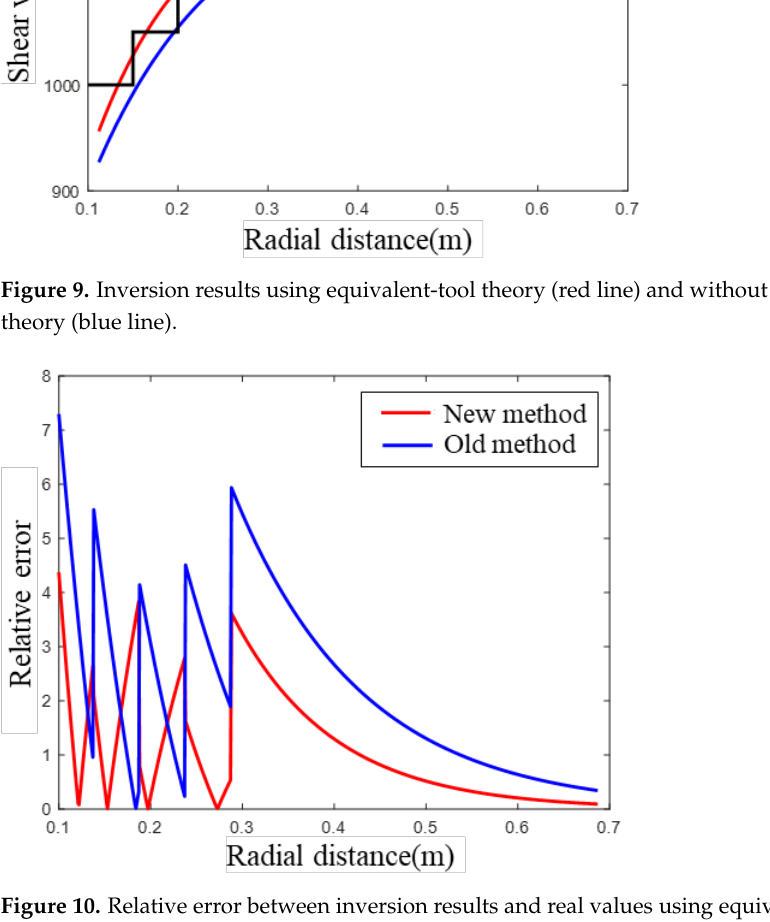
Figure 10. Relative error between inversion results and real values using equivalent-tool theory (red line) and without using equivalent-tool theory (blue line).